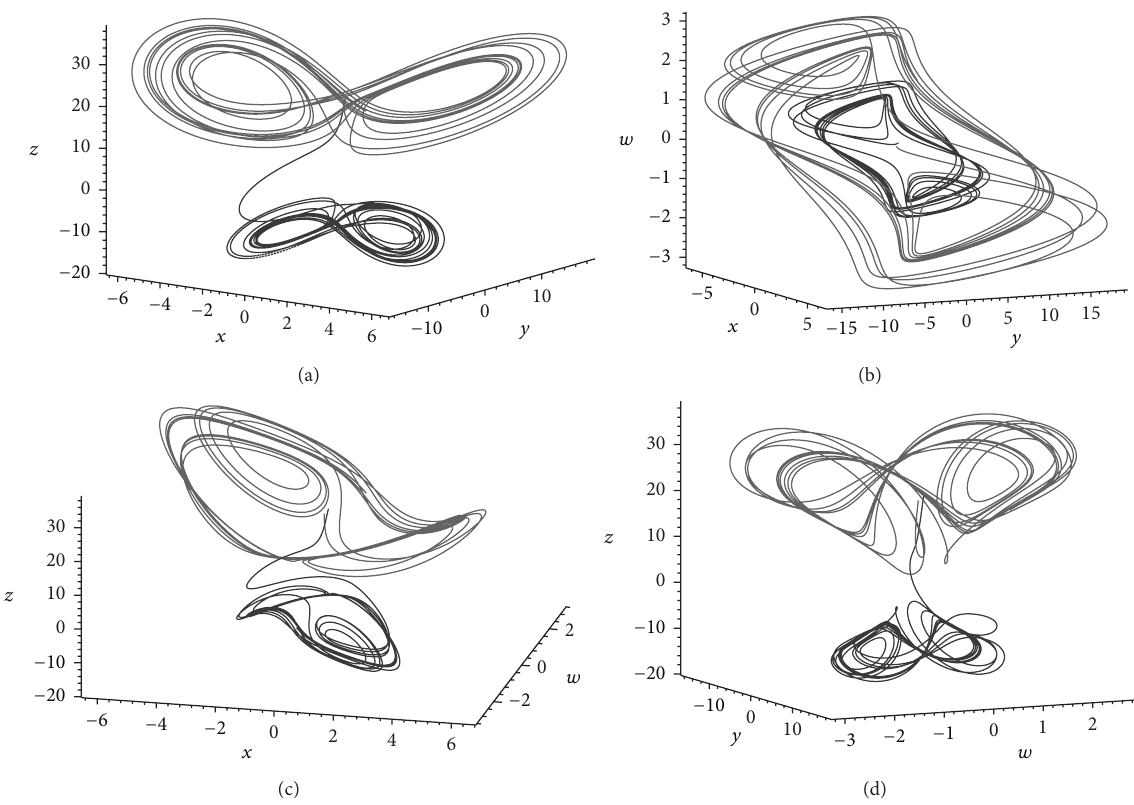
Figure 9: The projection of the synchronized attractors in different spaces: (a) (𝑥,𝑦, 𝑧) , (b) (𝑥,𝑦,𝑤) , (c) (𝑥,𝑤, 𝑧) , and (d) (𝑦, 𝑤,𝑧) . The solid line denotes and the drive system; the dashed line denotes respond system